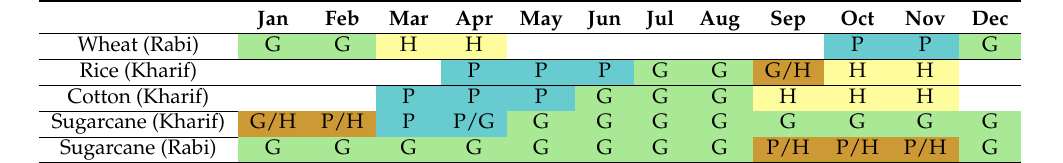
Table 2. Cropping calendar for wheat, cotton, rice and sugarcane (in rows). The blue/green/yellow boxes, labelled as P/G/H correspond to the planting/growing/harvesting phase. Brown boxes identify those periods of the year which can correspond to more than one phase, depending on the region. Source: Personal communication from Jam Khali (FAO-Pakistan).